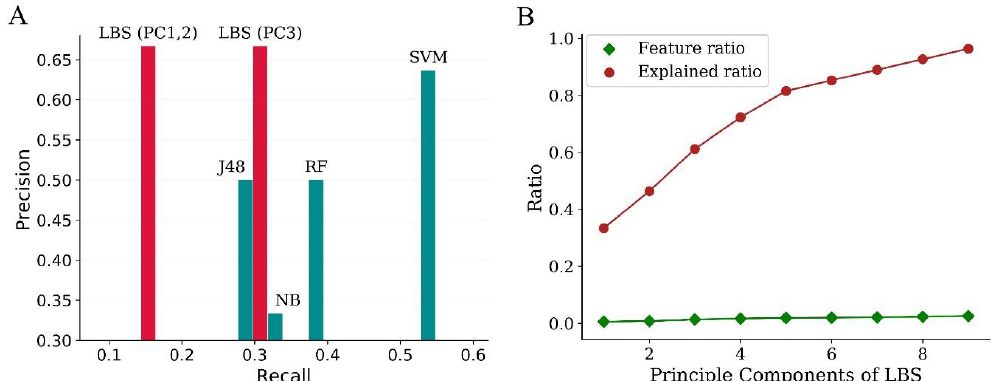
Figure 3. Comparison of LBS to other machine learning algorithms on dataset of inhibitors of Rho kinase 2. ( A ) Comparison of LBS to the four machine learning algorithms described by Schierz. ( B ) Relationship of feature ratio and sample ratio to principle components of LBS. NB: naive Bayes. RF: random forest. J48: J48 version of decision tree. PC: principle component.